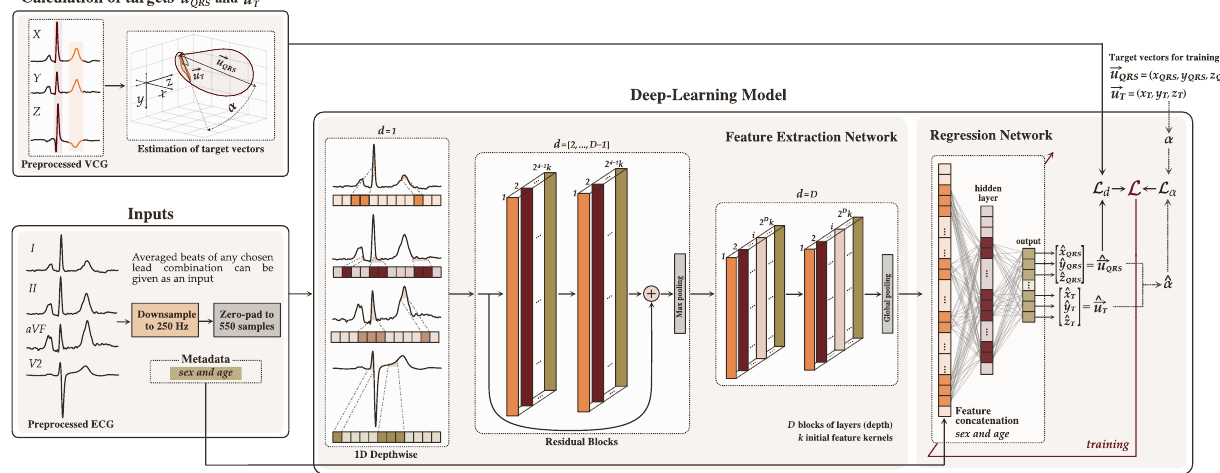
Figure 1. Overview of the proposed deep learning model for estimation of QRS-T angle using reduced-lead ECGs. The model is composed of two parts: feature extraction and regression. The #» #» u QRS and u T and spatial QRS-T angle α are computed from target vectors